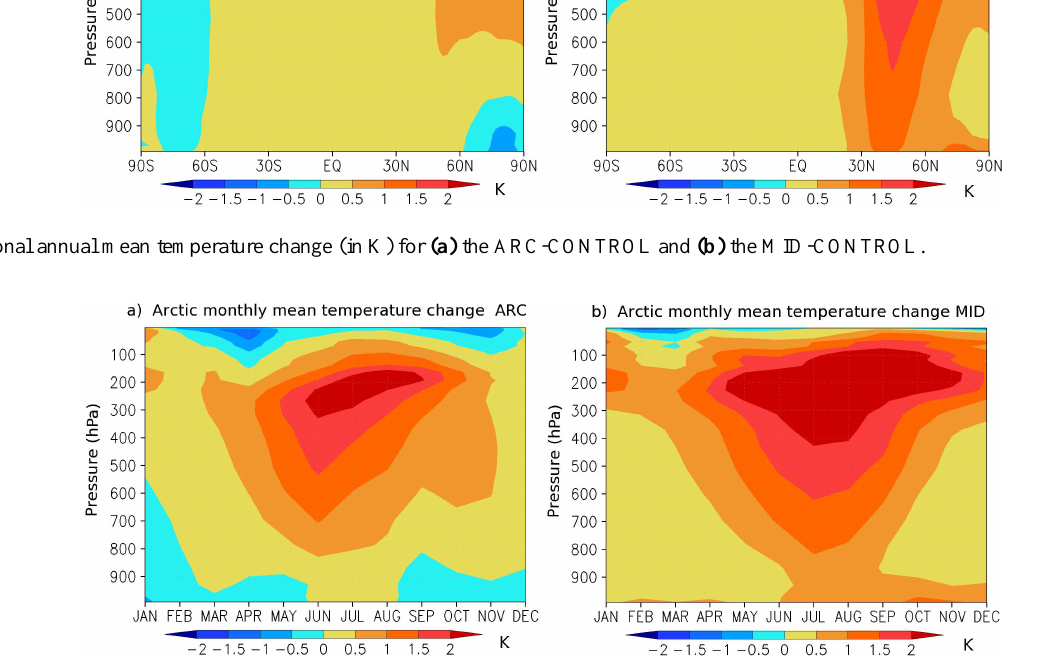
Fig. 6. Monthly Arctic mean (60–90 ◦ N) temperature change (in K) for (a) the ARC-CONTROL and (b) the